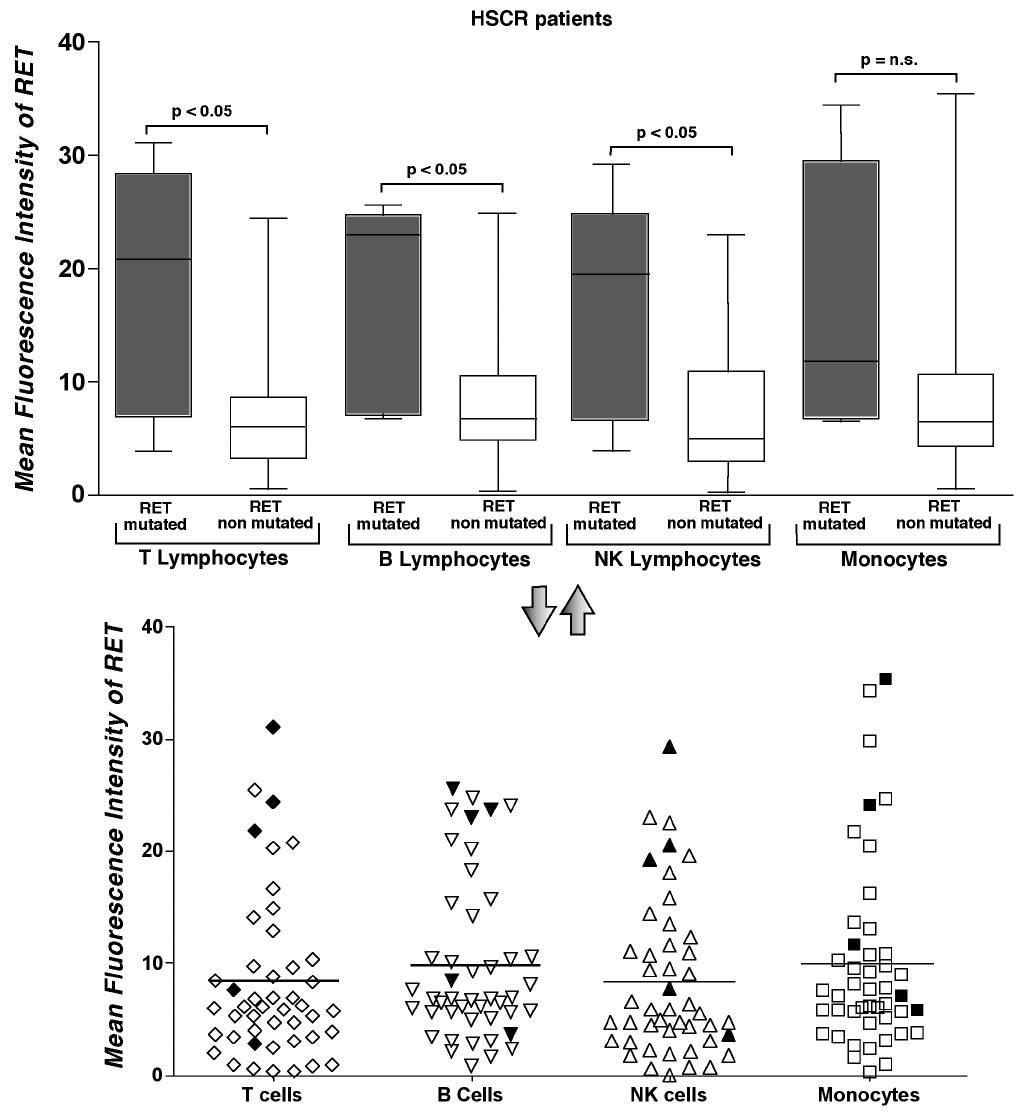
Figure 4. Expression of RET receptor on immune cells from HSCR patients associated with pathogenic mutations of RET gene. Summary graph of statistical histogram bars (upper panel) and dot plots (lower panel) showing MFI values of RET expressed on monocytes, T, B and NK lymphocytes from 46 HSCR patients stratified on the basis of individuals either carrying (gray histogram bars in upper panel and black symbols in the lower panel) or not carrying (empty histogram bars in upper panel and empty symbols in the lower panel) pathogenic RET mutation. 4 HSCR patients were excluded from the analysis because they were carrying mutations of the RET gene with uncertain effects.